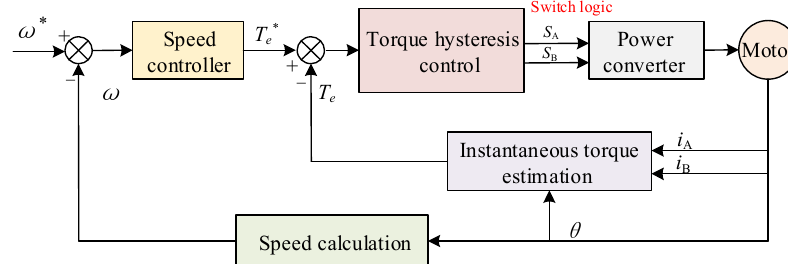
Figure 2. The control block of DITC strategy.